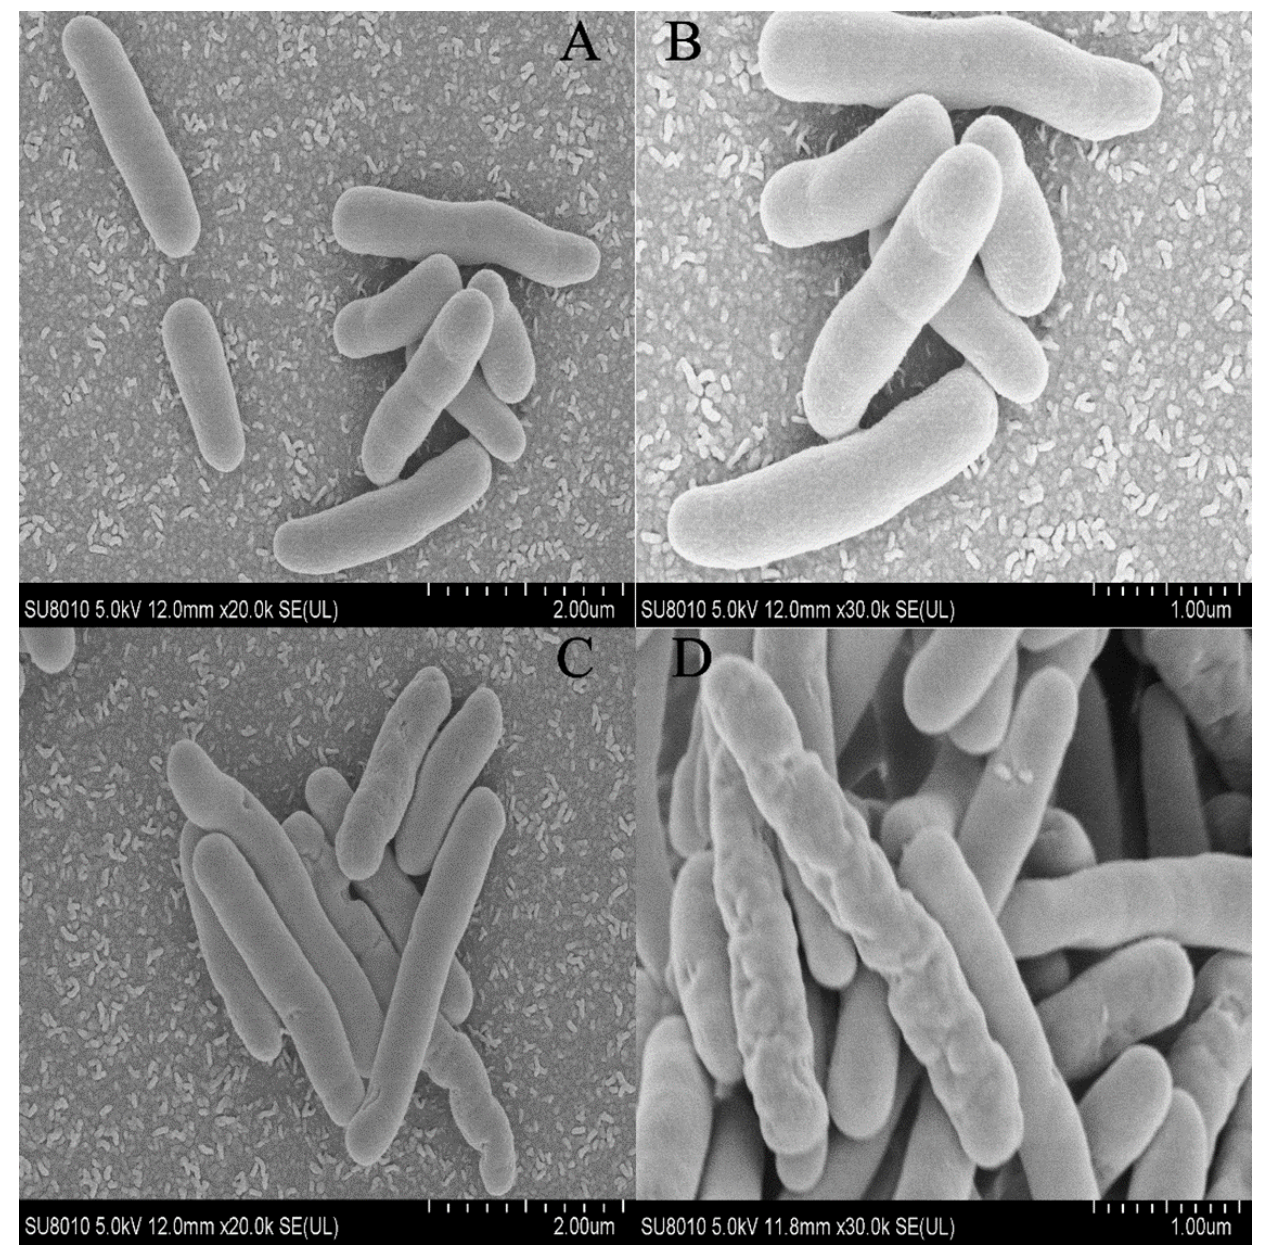
Figure 2. Scanning electron micrographs of P. lundensis cells after ( A , B ) DIW, ( C , D ) PALA (0.20%) treatment. The scan bars of 2( A ) and 2( C ) are 2 μm, and 2( B ) and 2( D ) are 1 μm.